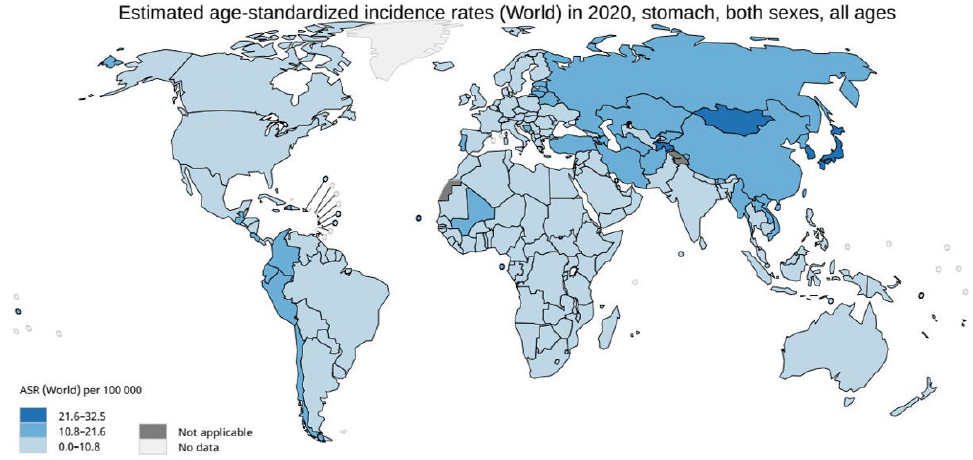
Figure 1. Age-standardized incidence rates (ASRs) of gastric cancer worldwide. High-risk areas: ASR ≥ 20 per 100,000 person-years (p-y), e.g., Japan, Korea, and China. Intermediate risk areas: ASR ≥ 10 and <20 per 100,000 p-y, e.g., Portugal, Lithuania, Romania, and